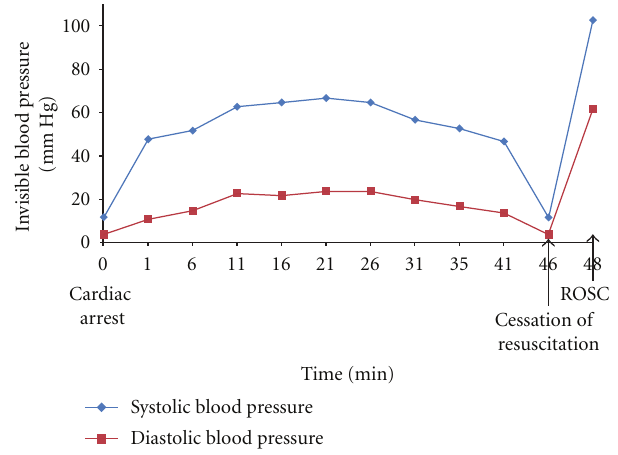
Figure 1: Blood pressure (BP) fluctuation during cardiac arrest in our